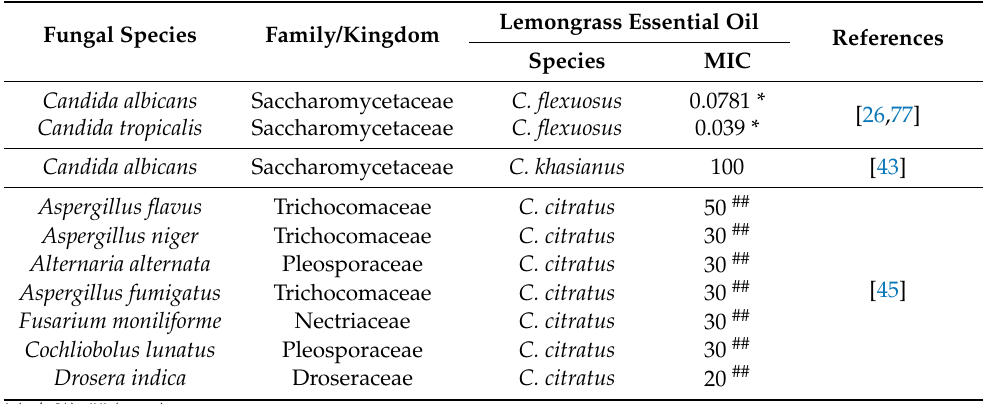
Table 3. The efficacy of essential oils obtained from different lemongrass species against some common pathogenic fungi. MIC, minimum inhibitory